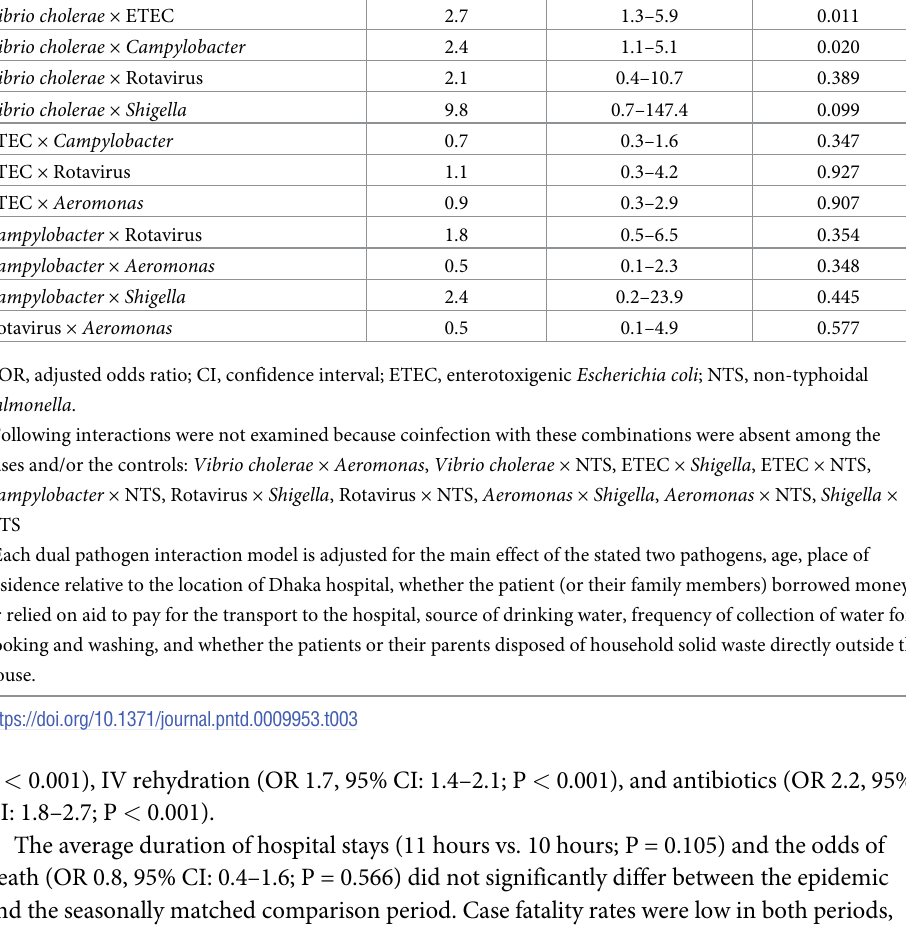
Table 3. Adjusted odds ratio of presenting with diarrhea during the epidemic (compared to the comparison period) for all possible a dual pathogen interaction from multivariable logistic regression models. Interaction AOR b 95% CI P